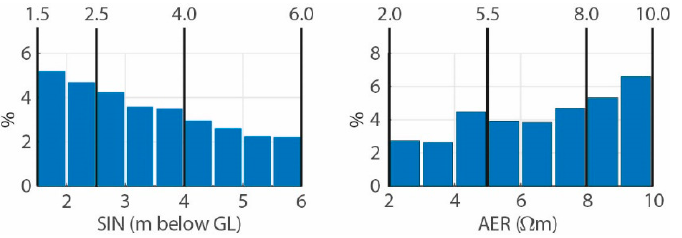
Figure 5. Classification of the sensitivity layers: ( a ) saltwater distance (SAD), ( b ) freshwater distance (FRD), ( c ) ground elevation level (GEL), ( d ) permeability (PER), ( e ) potential runoff (ROF), and ( f ) relative ground-level change (RGLC). Scores from 0 to 4 identify low-to-high contributions to vul- nerability. Note that PER layer combines permeability and geomorphological structures. Coordi- nate system: UTM33, WGS84.